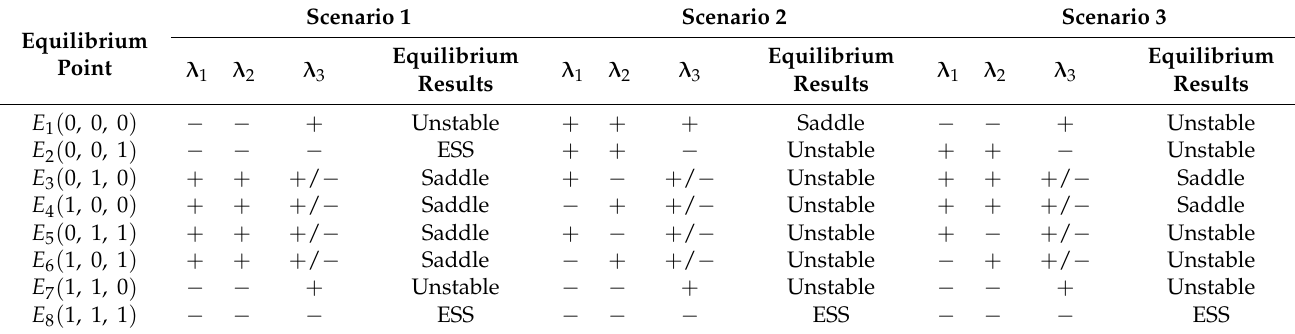
Table 4. Stability analysis of equilibrium